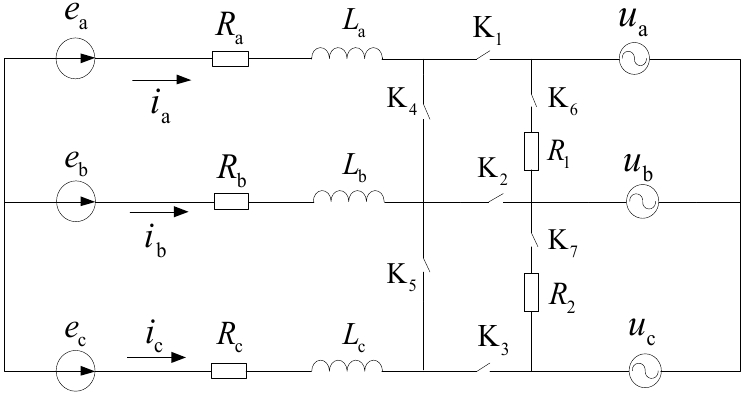
Figure 3. Equivalent circuit diagram of rotor winding.